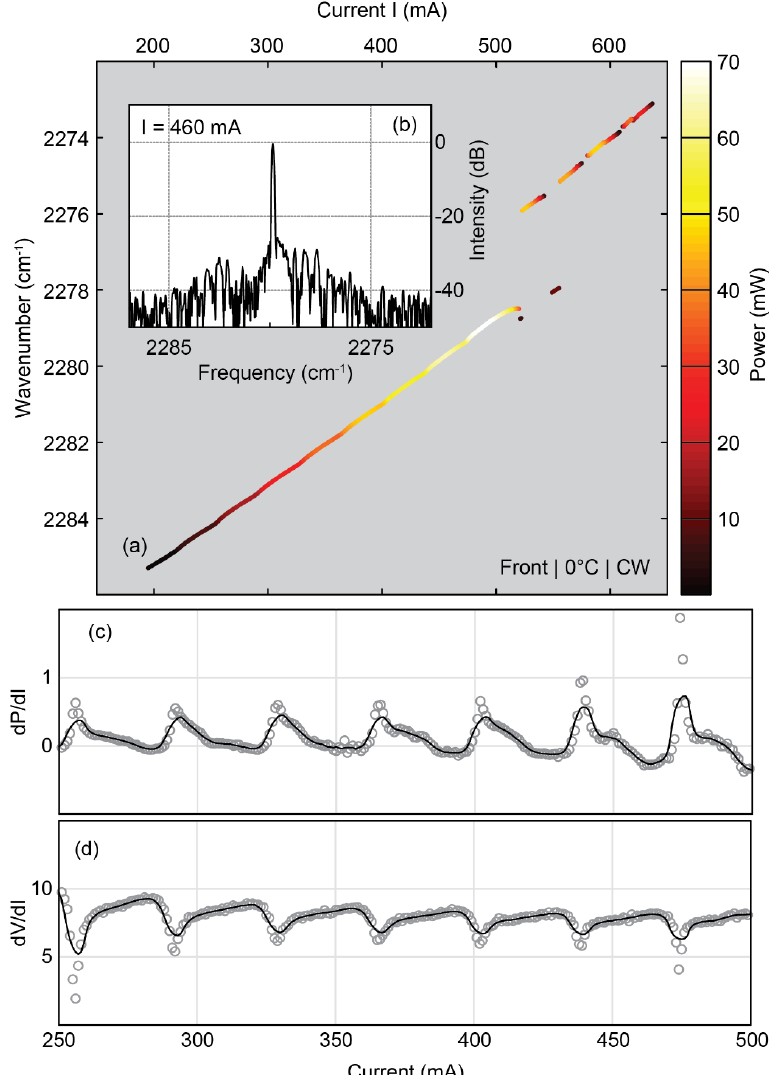
Figure 2. Analysis of etaloning behavior observed in spectrally resolved LIV characteristics. ( a ) Mode map of the front section; ( b ) Spectra recorded at 460 mA pumping current showing a SMSR of 25 dB. The derivative of the power ( c ) and the voltage ( d ) reveal a reciprocal behavior, the typical sign of photo-induced current.